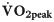
Scatter plots of SctO2rest and SctO2peak against V˙O2peak, BNP and OUES.